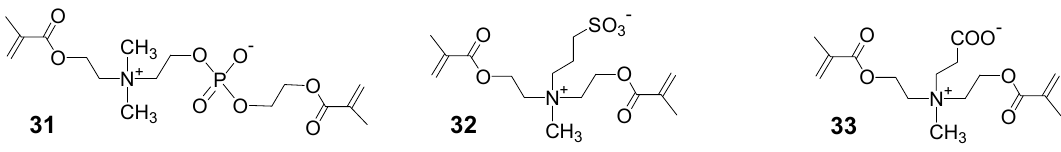
Figure 5. Examples for zwitterionic crosslinkers incorporating phosphobetaine [176–178], sulfobetaine [179] or carboxybetaine [180,181]